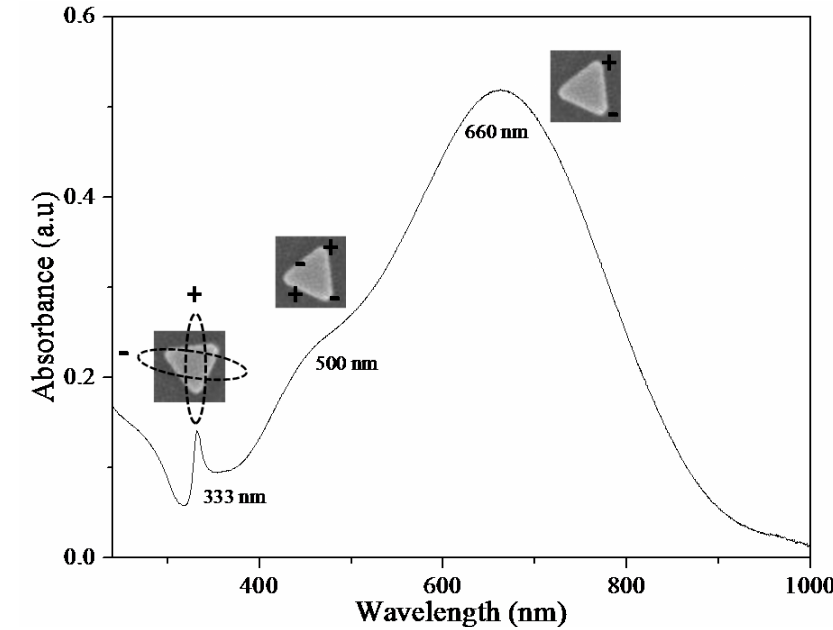
Figure 1. Optical absorbance with corresponding mode of plasmon excitation of resuspended triangular silver nanoplate